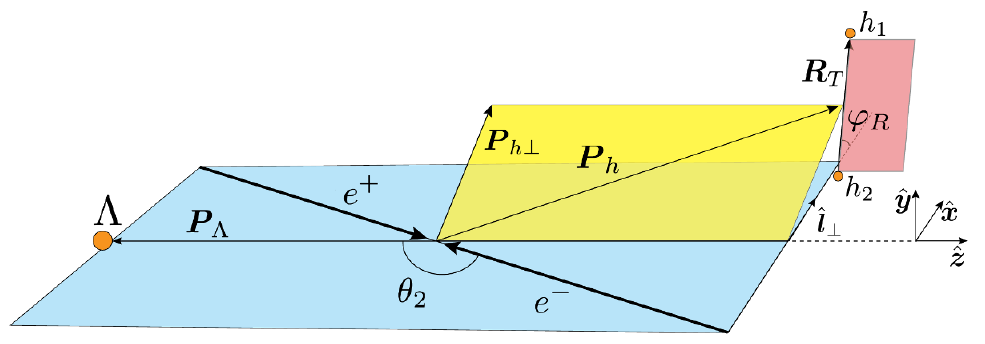
Figure 1 . The kinematics of e + e (cid:0) ! h 1 h 2 + (cid:3) + X